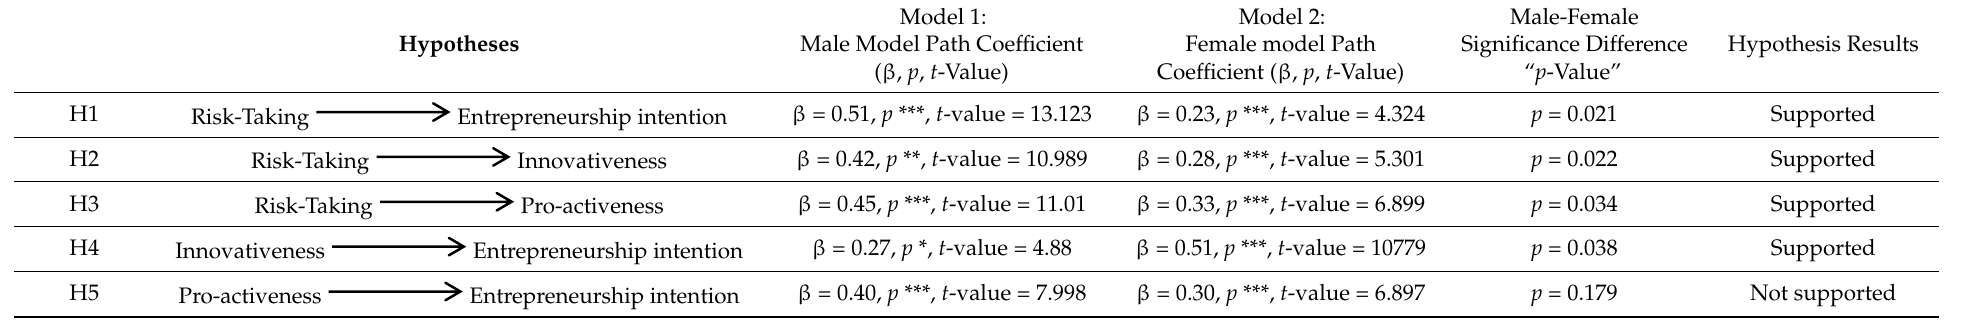
Table 4. SEM Multi-group analysis—(Male-Female). Table 3. The structural model’s results .